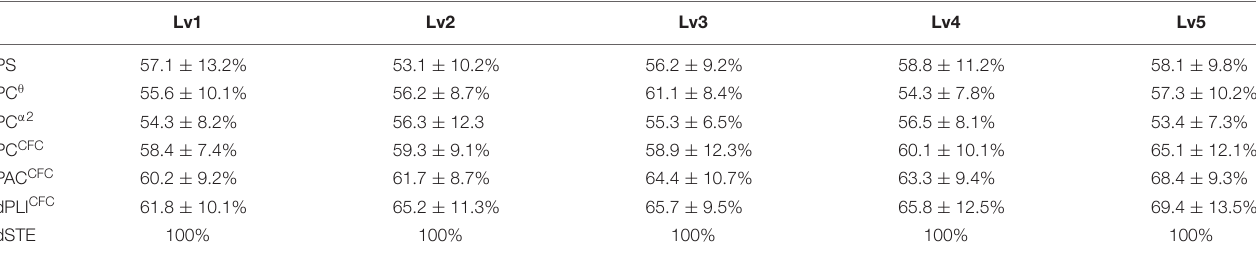
TABLE 2 | Classification behavioral performance based on power spectrum (PS), phase coupling (PC), phase-to-amplitude cross-frequency coupling (CFC), causal phase relationships directed phase lag index (dPLI) and delay symbolic transfer entropy